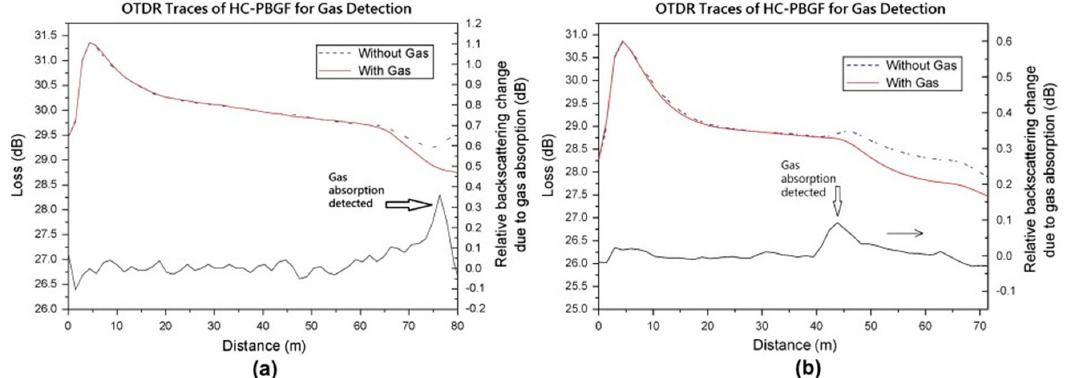
Figure 9. Distributed measurement of 10% acetylene based on a hollow-core fibre. (a) The gas was filled at the end of the fibre; (b) the gas was filled at 44 m of the fibre. The upper lines represent the measured OTDR traces, and the lower curves show the slope difference between the red line and dotted line. Reproduced with permission from Reference [52].